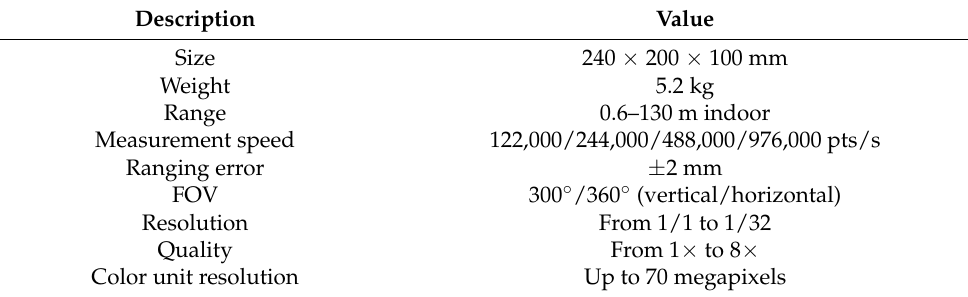
Table 5. Technical specifications of the FARO Focus 3D X 130 laser